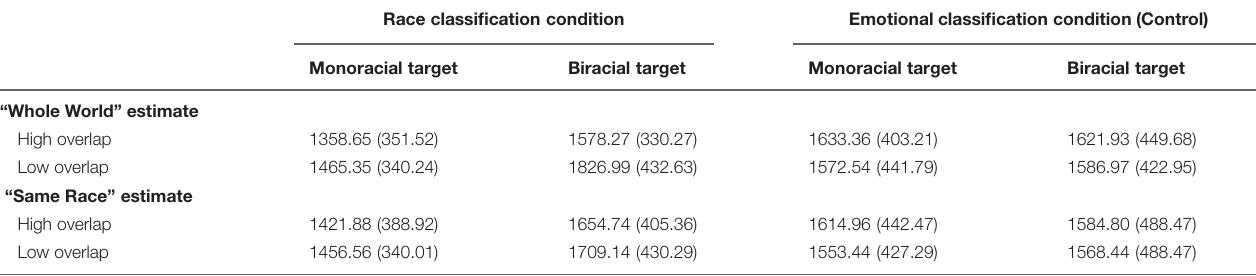
TABLE 1 | Study 2 response